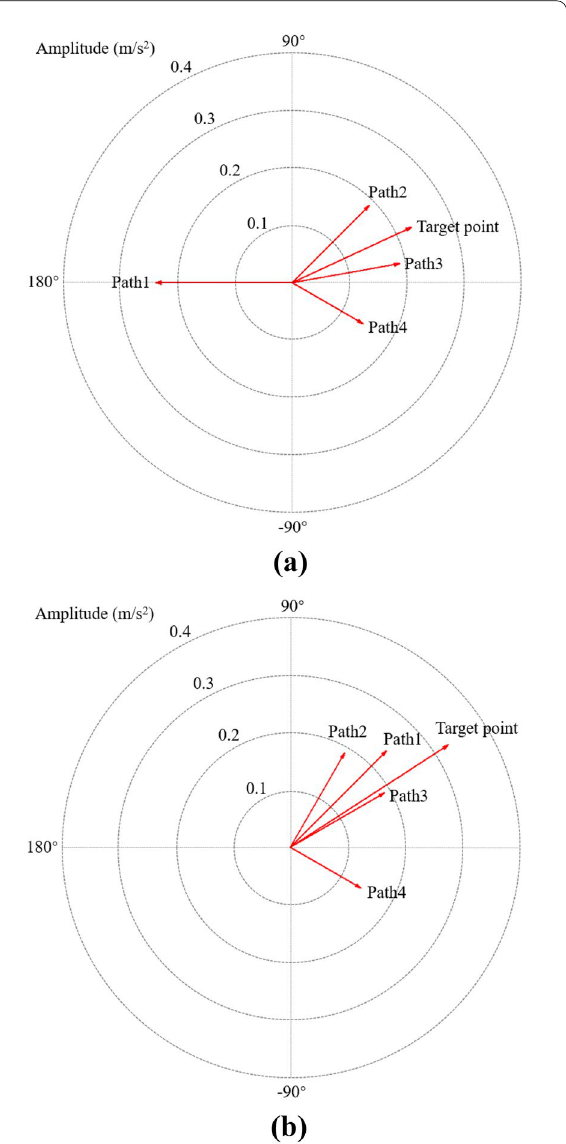
Figure 4 The vector diagram of the transfer paths at 200 Hz for a Operation 1 and b Operation